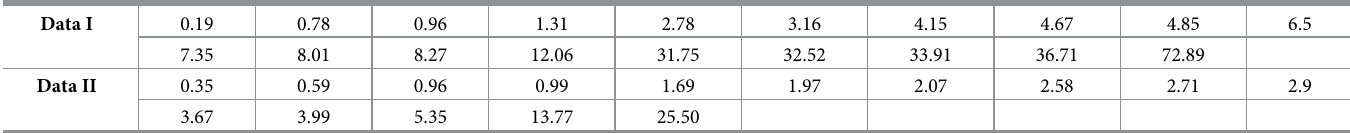
Table 10. Breakdown times (in minutes) for data I and data